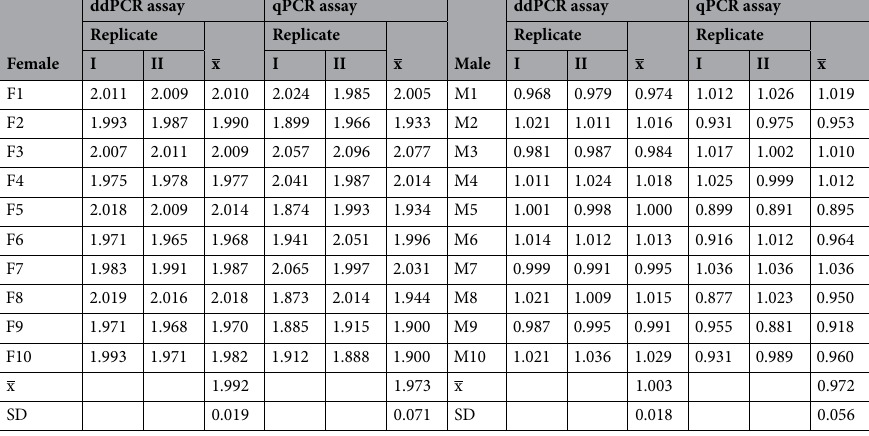
Table 3. Comparison of CNV values detected by ddPCR and qPCR in the collection